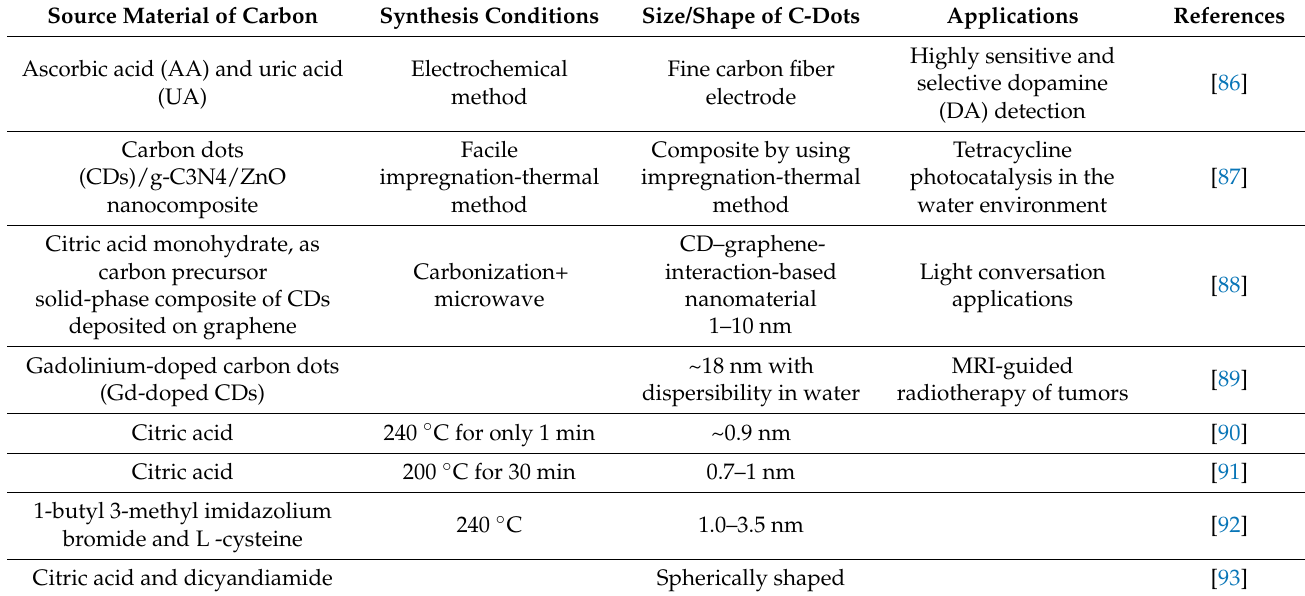
Table 5. Thermal-decomposition-based synthesis of C-dots.